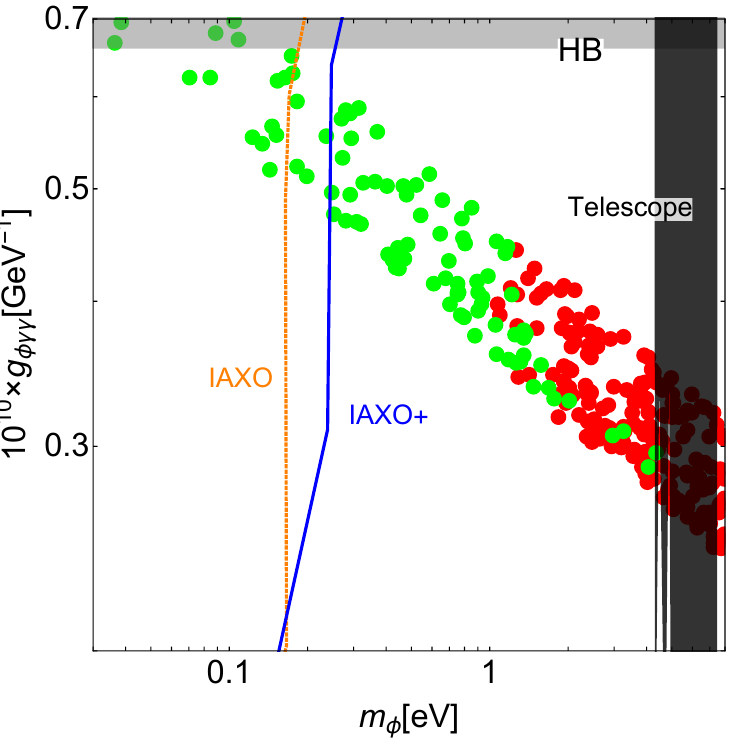
Figure 6 . Scatter plot of the viable parameters consistent with the CMB observation and the dark matter abundance, if the reheating proceeds mainly through the ALP coupling with (cid:28) leptons. The red (green) points represent that c (cid:28) is greater (smaller) than